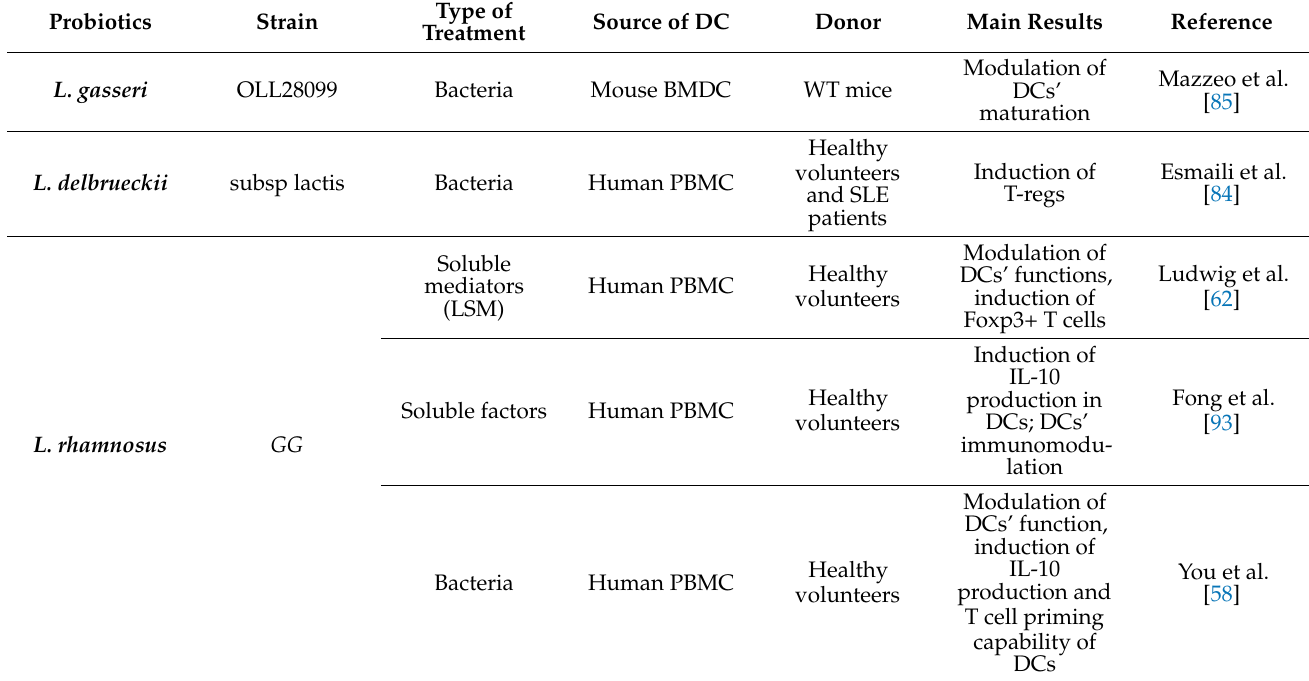
Table 1. Probiotics, post-biotics, and para-probiotics: tolDC induction and other effects.